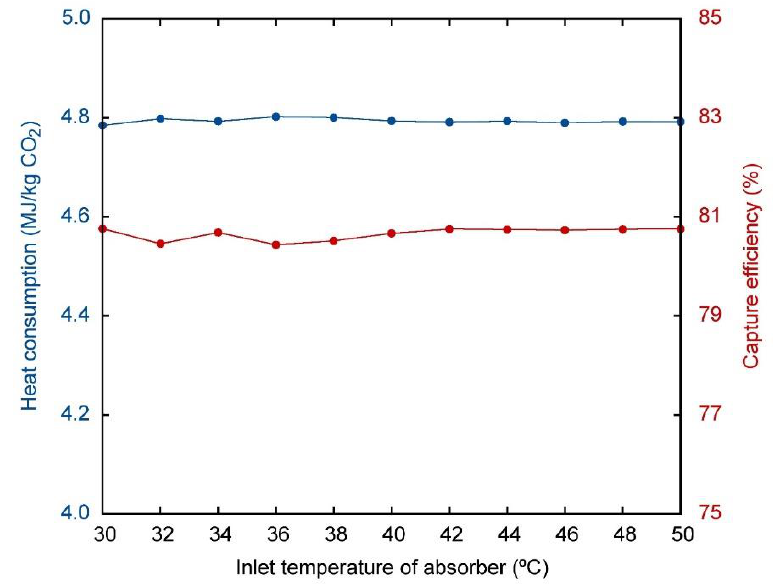
Figure 4. Variation of inlet temperature versus heat consumption and capture efficiency.